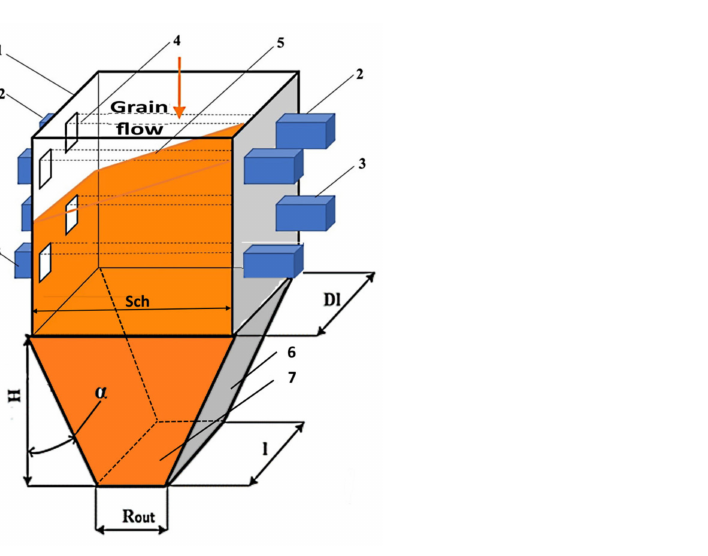
Figure 1. Microwave—convective grain processing zone with an unloading hopper: ( 1 ) Casing of convective-microwave zone; ( 2 ) Upper row of magnetrons; ( 3 ) Lower row of magnetrons; ( 4 ) Radio- transparent walls that enable microwave field enter the grain layer; ( 5 ) Grain layer; ( 6 ) Unloading hopper; ( 7 ) Outlet; (Rout) Outlet width; (l) Outlet length, (H) Height of unloading hopper; ( α ) Slope of unloading hopper